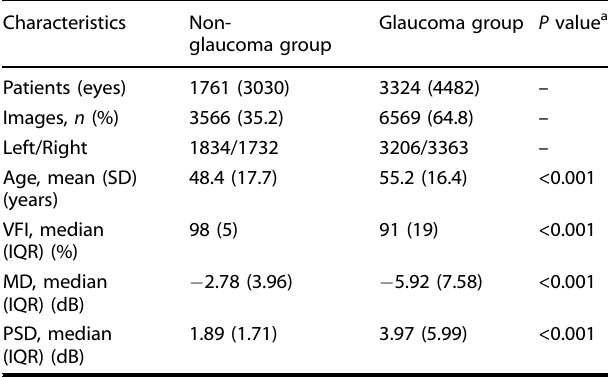
Table 1. Baseline characteristics of study participants in Phase